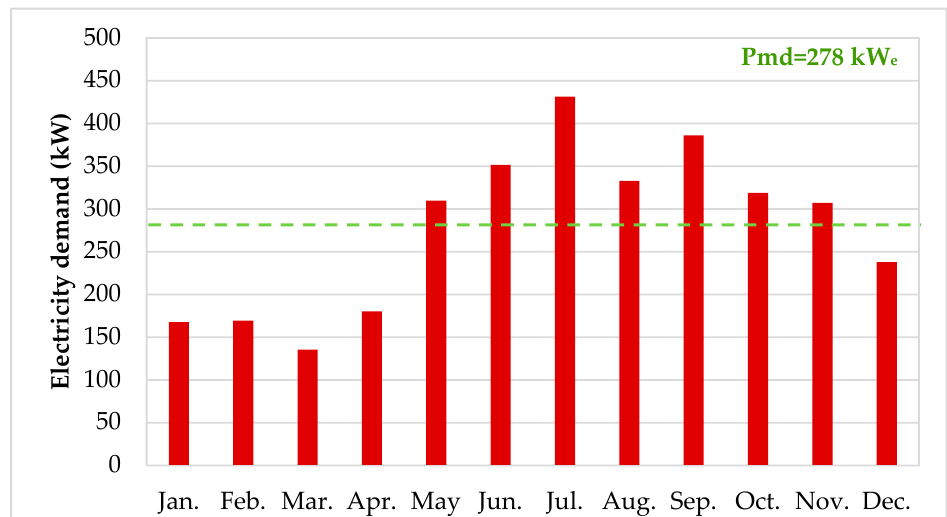
Figure 8. Average monthly electricity demand.